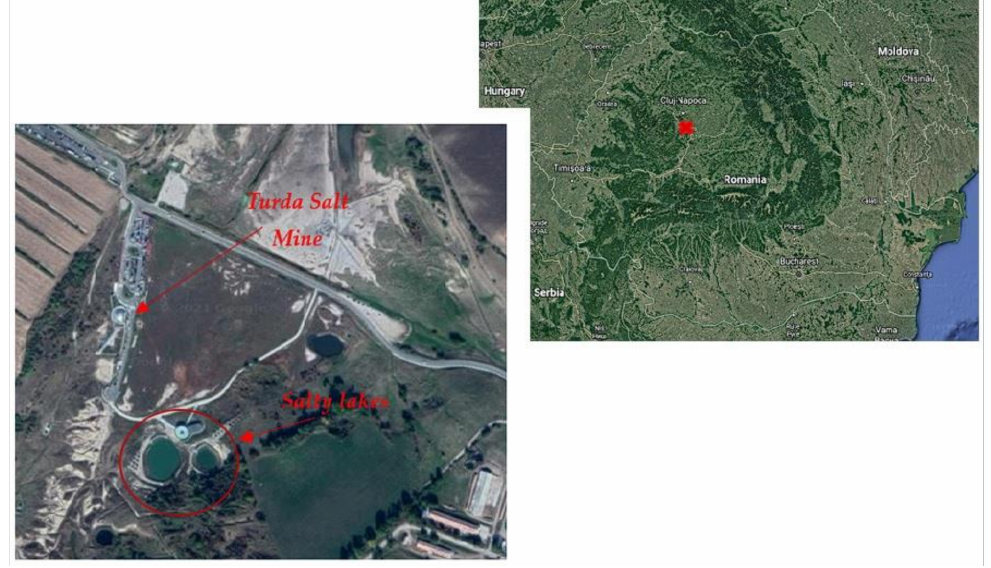
Figure 1. Satellite view